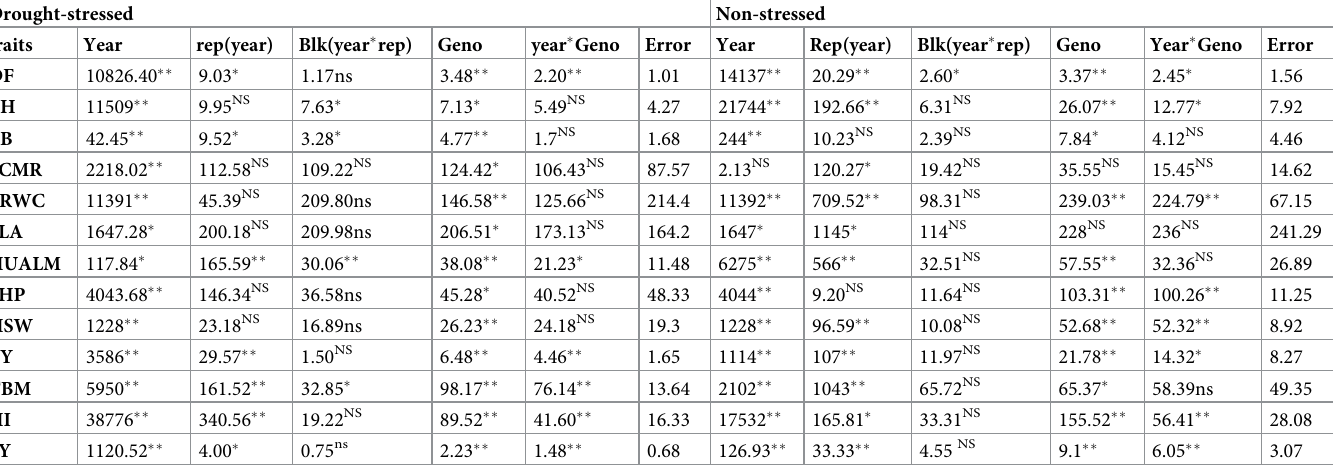
Table 2. Analysis of variance showing mean square values due to year, replications (Rep), blocks (BLK), genotypes (Geno), and genotype by year and error 13 phe- notypic traits among 100 groundnut genotypes across two seasons evaluated under drought-stressed and non-stressed conditions. Drought-stressed